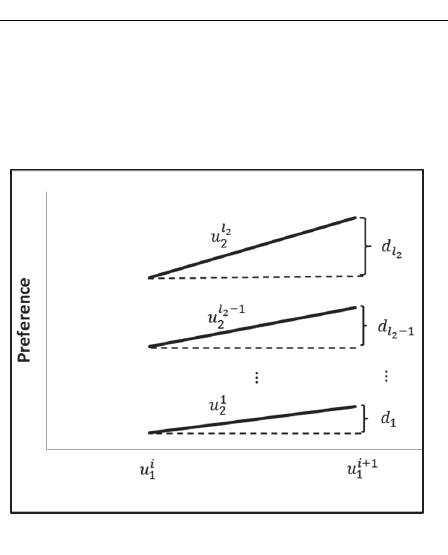
Conditions required to model change in preference difference by unipolar capacity Plot of preference differences